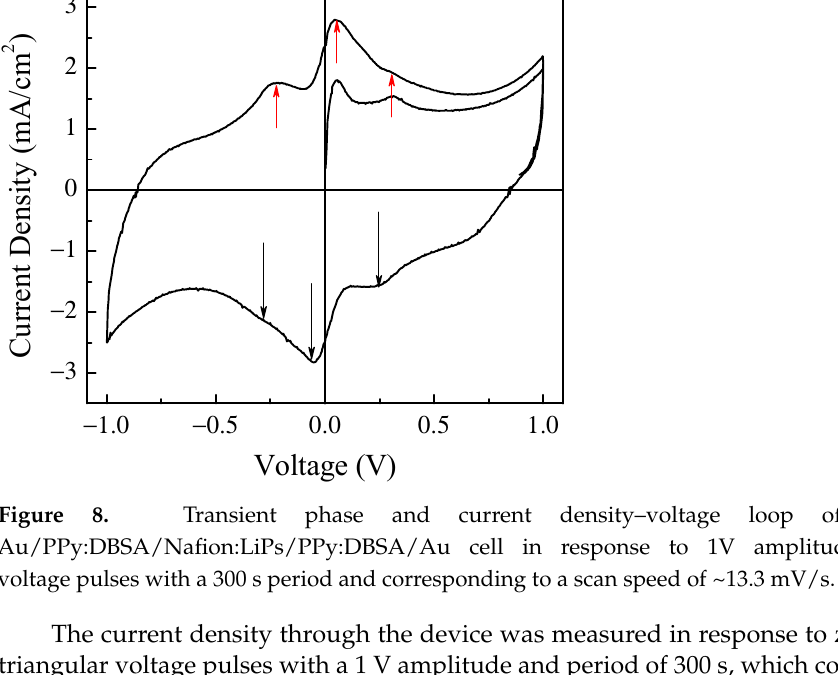
(a) Figure 7. Frequency dependence of the real part of the impedance of a PPY:DBSA film ( a ) and of a PPy-GNP:DBSA film ( b ). The imaginary part of the impedance is negligible in both cases at all of